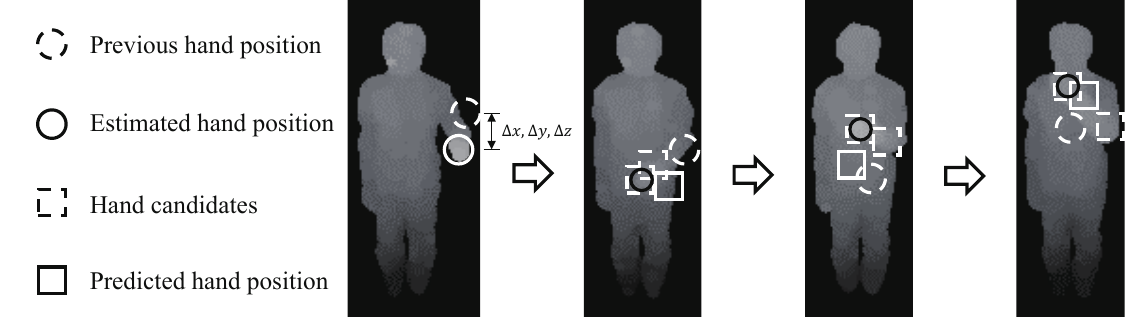
Figure 4. Example of the measurement update step when the hand occludes the torso. The hand tracker extracts the depth measurements for hand candidates. The final hand position is estimated by the depth measurement with the smallest Mahalanobis distance from the previous hand